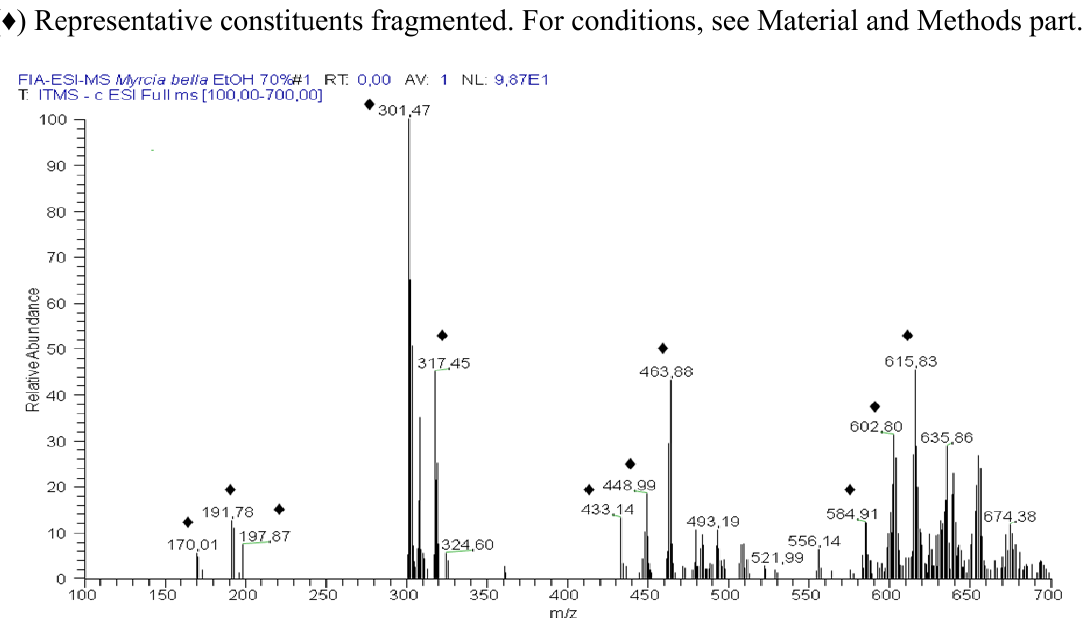
Figure 3. Typical direct flow injection analysis FIA-ESI-IT-MS fingerprint spectra obtained in negative ion mode of the 70% EtOH from the leaves of M. bella